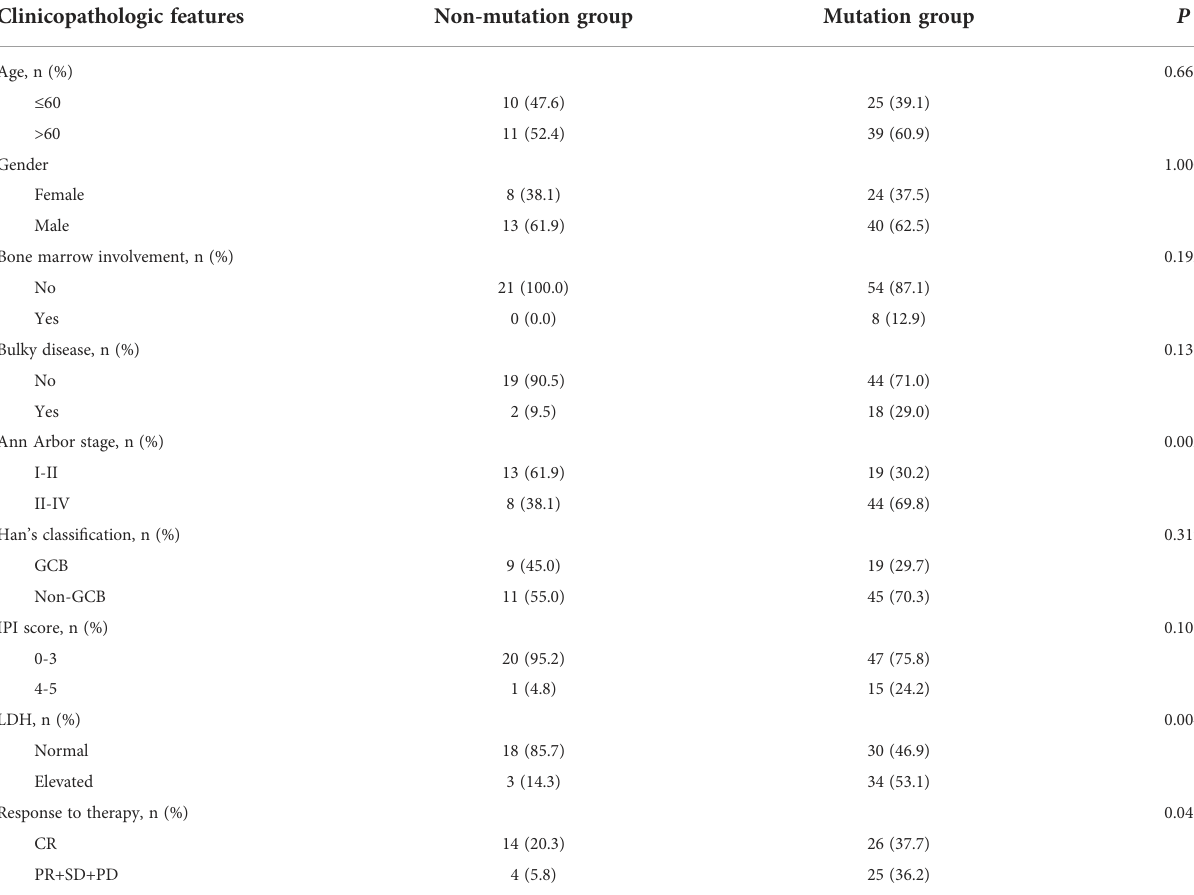
TABLE 1 The clinicopathologic features of DLBCL patients with mutation or without in training group. Clinicopathologic